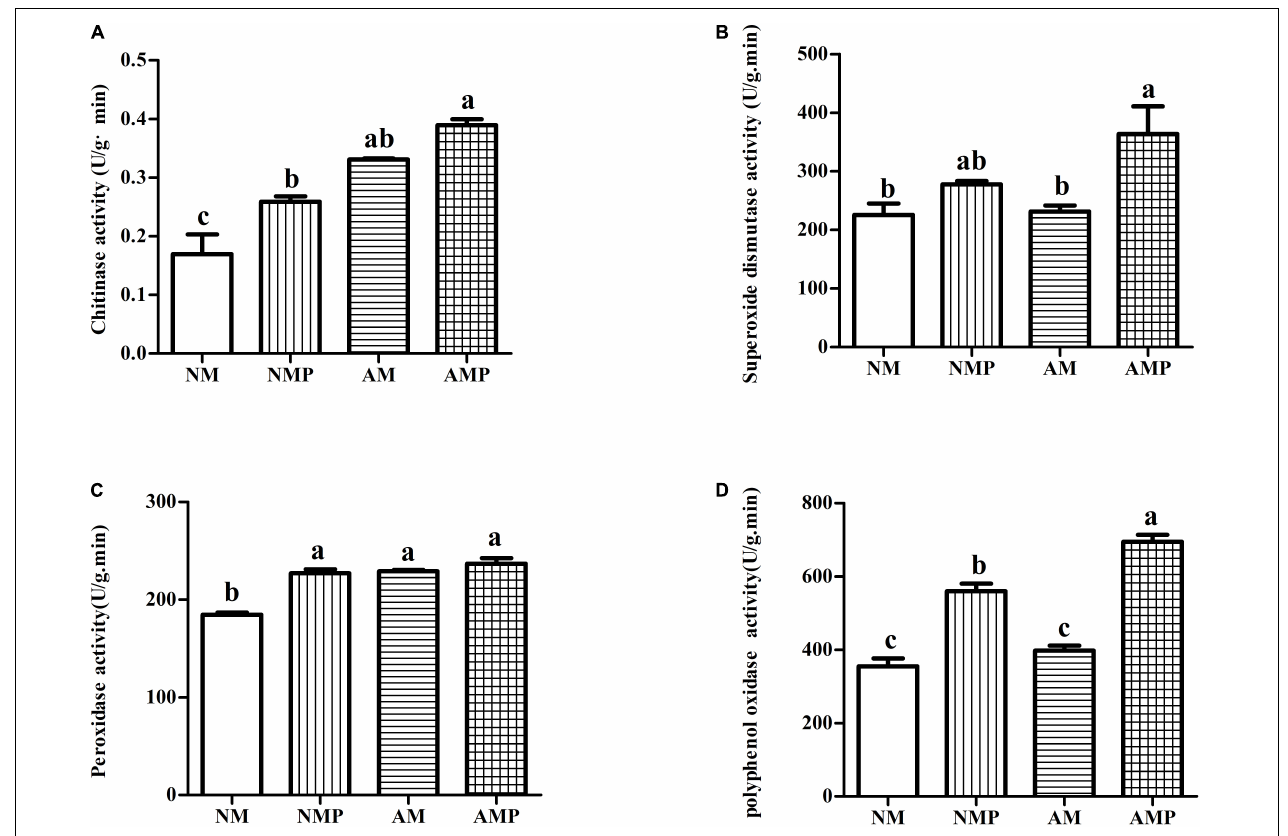
FIGURE 3 | Chitinase (A) , superoxide dismutase (B) , peroxidase (C) , and polyphenol oxidase (D) activity of common vetch under arbuscular mycorrhizal and disease treatments. NM = uninoculated with S. tortuosa , AM = inoculated with S. tortuosa , NMP = NM inoculated with C. lentis , and AMP = AM inoculated with C. lentis . Different lowercase letters on the bars means there is significant difference across treatments at P < 0 . 05 by Tukey’s HSD test.